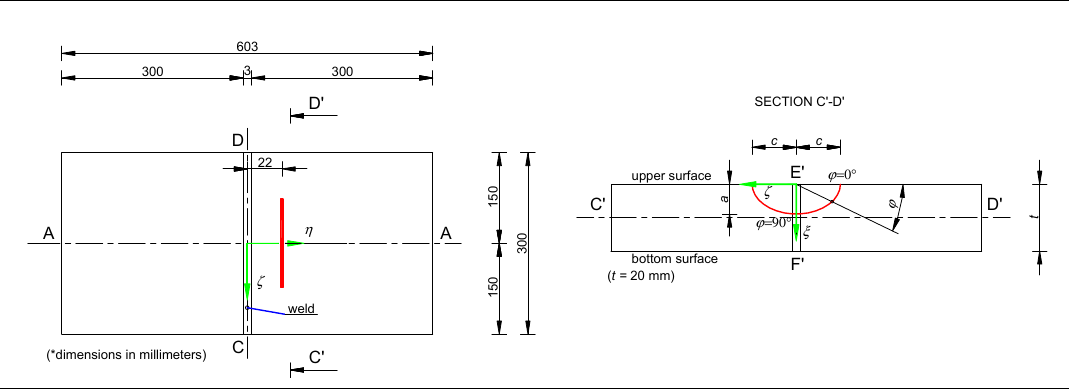
Figure 4. Illustration of shape, dimensions, location, and orientation of cracks parallel to the weld line.